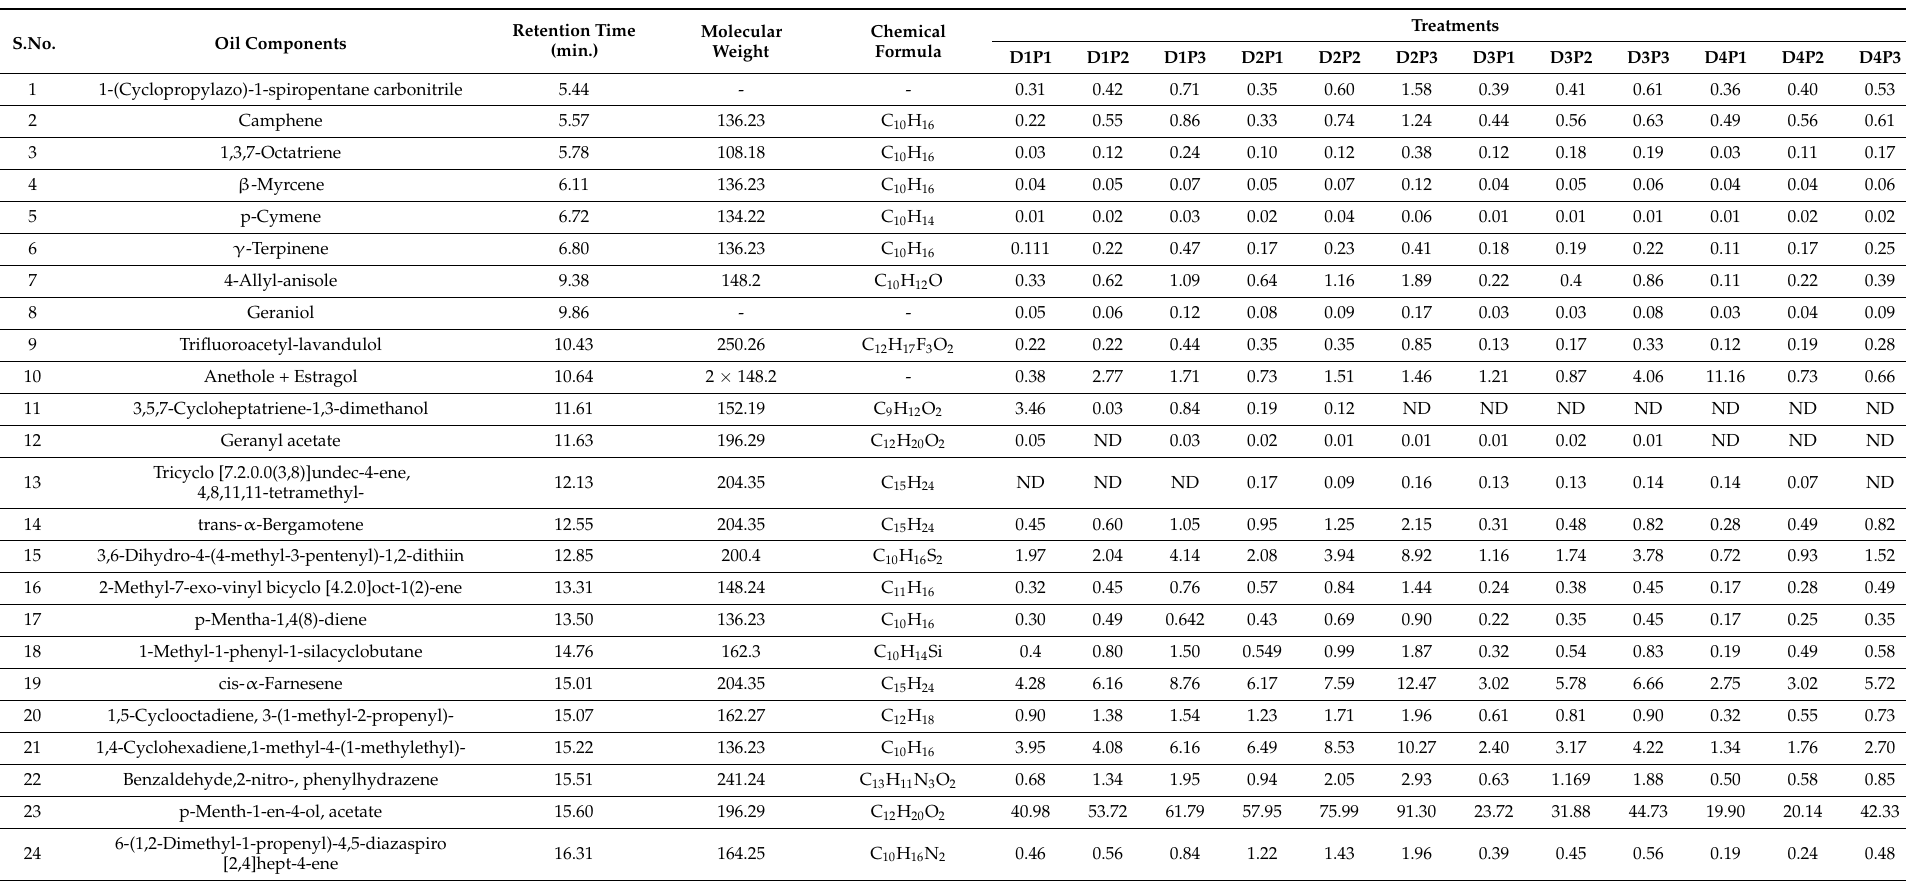
Table 3. Effect of date of sowing and spacing of plants on the essential chamomile oil profile (percentage of essential oil) in GC/MS in the experimental